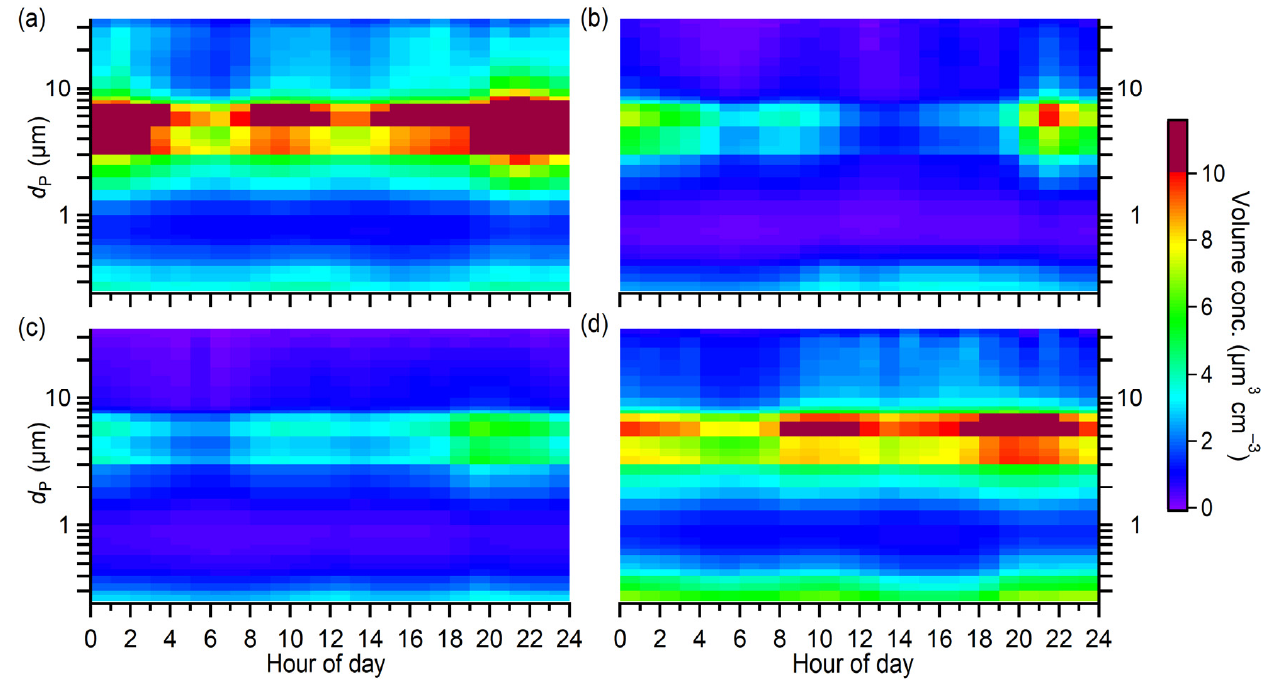
Figure 5. Diurnal profiles of the size-resolved PM volume concentrations for individual seasons: ( a ) spring, ( b ) summer, ( c ) fall, and ( d ) winter.